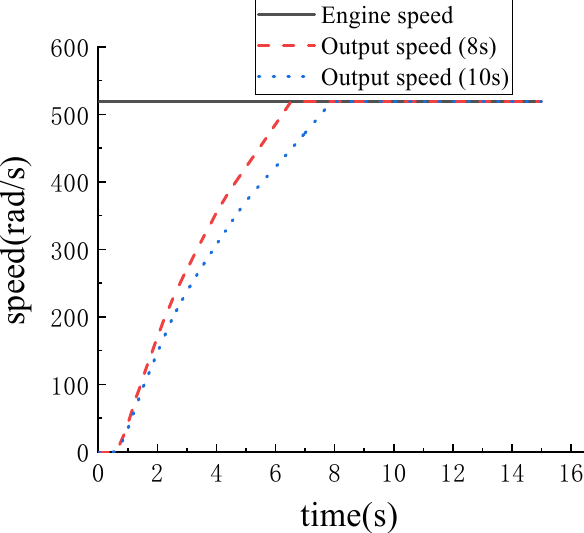
Figure 11. Speed curve for conventional fixed slope engagement pressure loading.